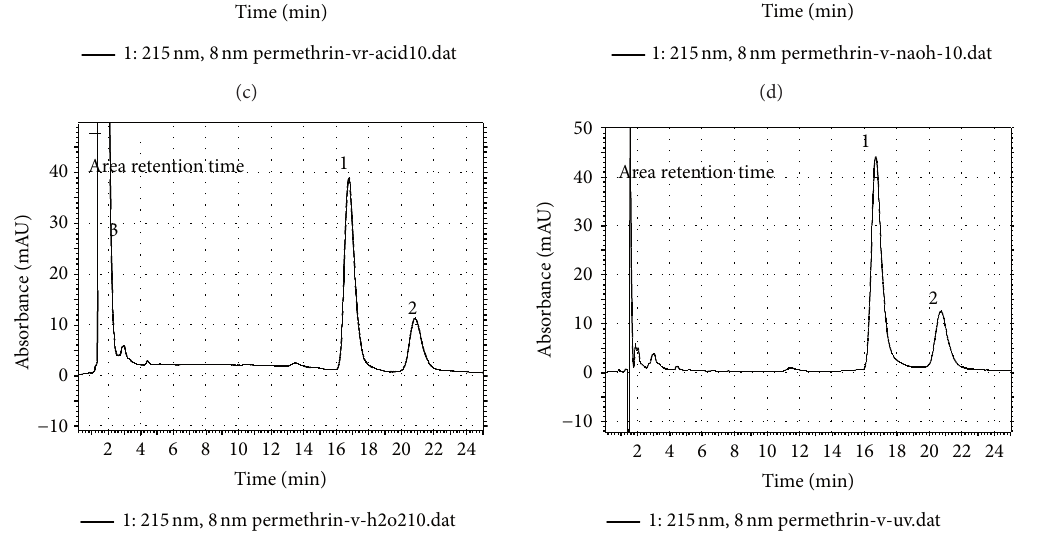
F 3: Typical chromatograms of: (a) permethrin working standard solution (10 (c) acidic hydrolysis: peaks 3, 4, 5, and 6 = degraded forms; (d) basic hydrolysis: peaks 3, 4, and 5 degraded forms; (e) oxidative